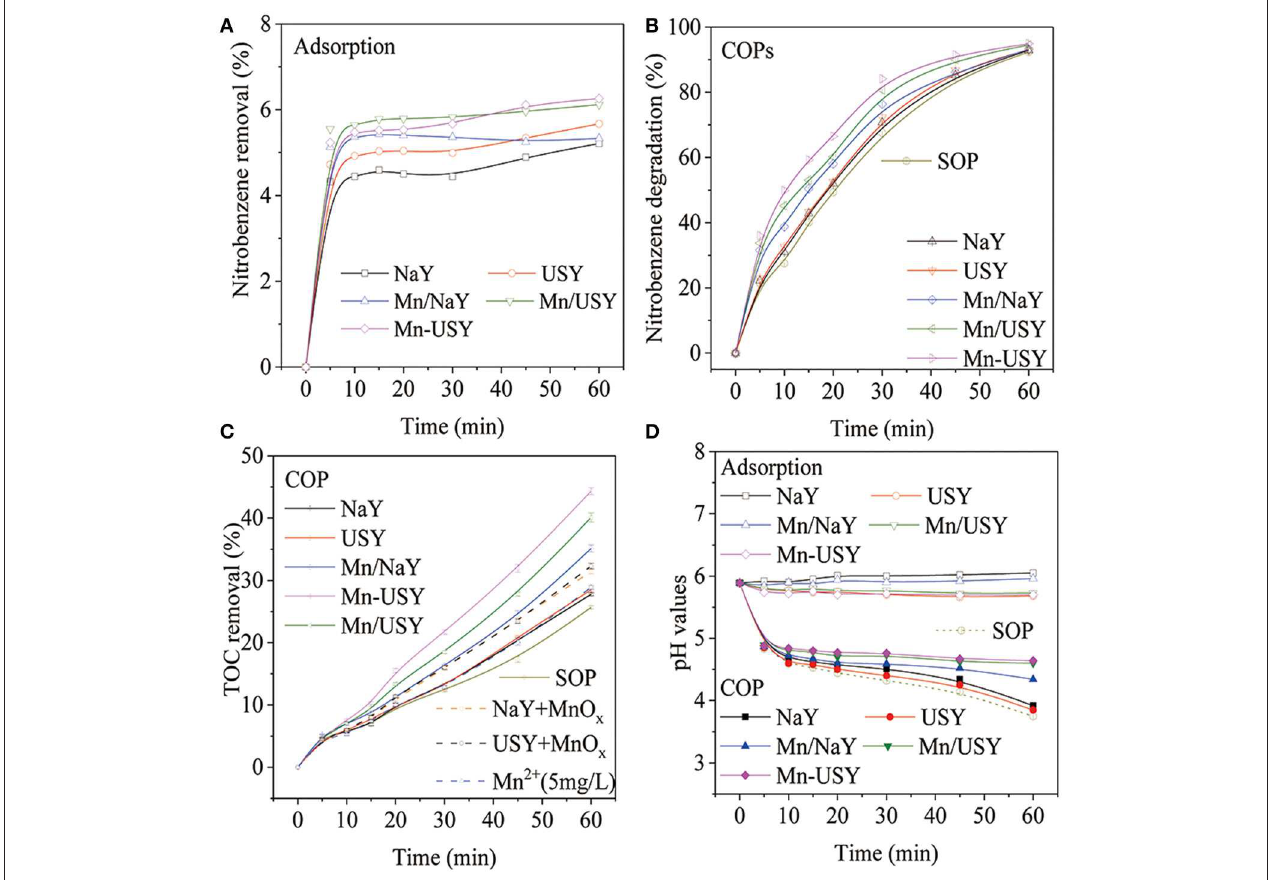
FIGURE 6 | Nitrobenzene removal by adsorption (A) , nitrobenzene degradation after COPs (B) , TOC removal after COPs (C) , and pH changes (D) with catalysts (0.5g catalyst, ozone 7.5mg · min − 1 , initial solution pH 5.89, reaction temperature 25 ◦ C and 60min treatment).